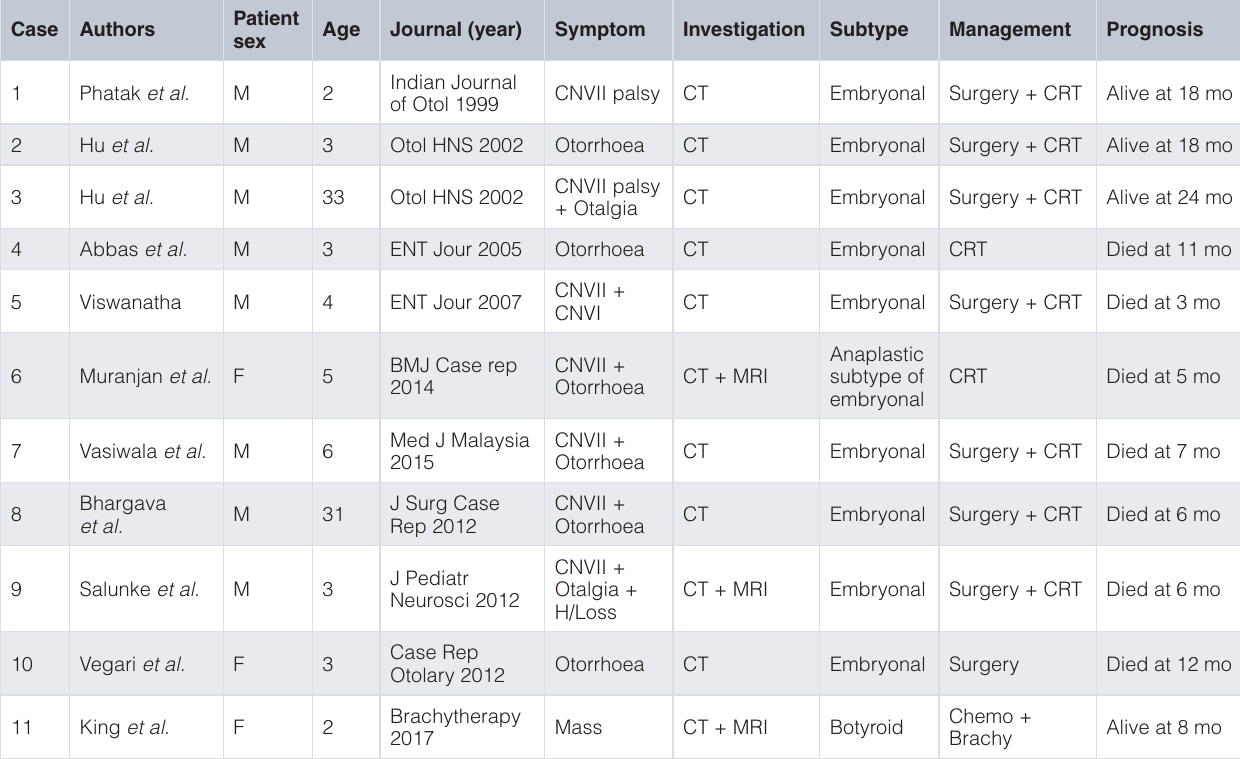
Table 1. Summary of case